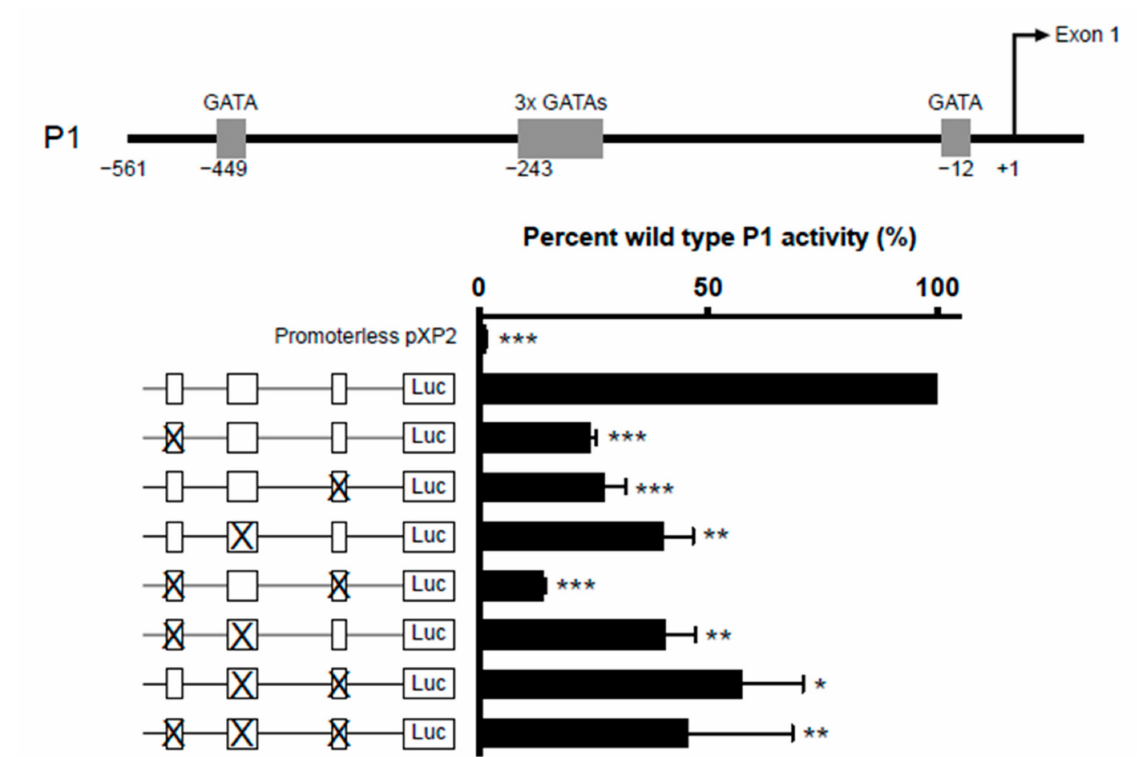
Figure 5. Combinatorial mutagenesis reveals positive regulation of IL5RA P1 activity by multiple GATA sites. Substitution mutations were introduced into the GATA sites in the IL5RA P1 promoter at positions − 449, − 243 (triple GATA site) and − 12 singly or in combination. For the mutation of the triple GATA site, all three GATA sites were mutated. AML14.3D10 eosinophilic myelocytes were transiently transfected with the IL-5R α P1 luciferase promoter reporter construct containing the wild-type or mutated GATA sites with a pRL-TK expression vector as an internal control for transfection efficiency. Promoter activities were measured 6 h post-transfection and were normalized by the dual luciferase method. Data are shown as mean percent wild-type P1 activity for three independent experiments. * p < 0.05 ** p < 0.01 *** p <